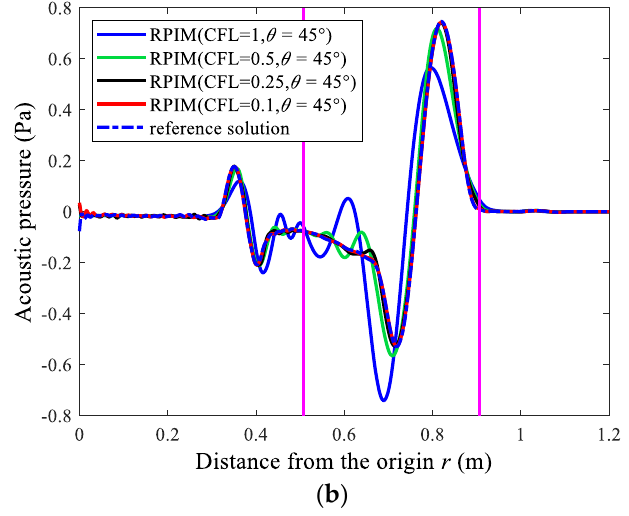
Figure 18. The transient responses of the acoustic pressure distributions at different time points from RPIM for the two-dimensional scattering problem by using the varying non-dimensional time integration steps: ( a ) t = 0.4 s; ( b ) t = 0.7 s.